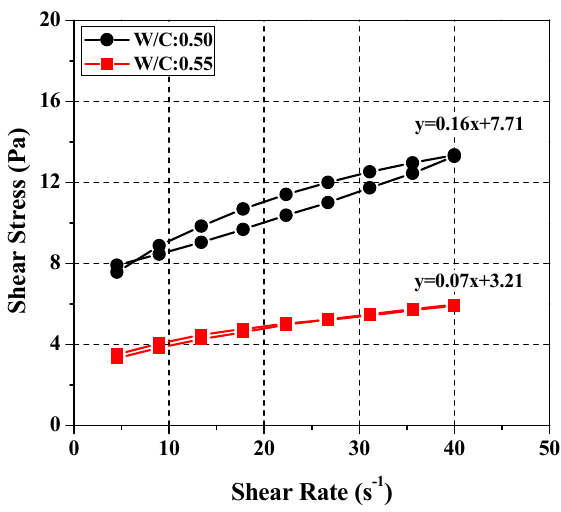
Figure 10. Test results of rheology for cement paste ( W / C = 0.50, 0.55).